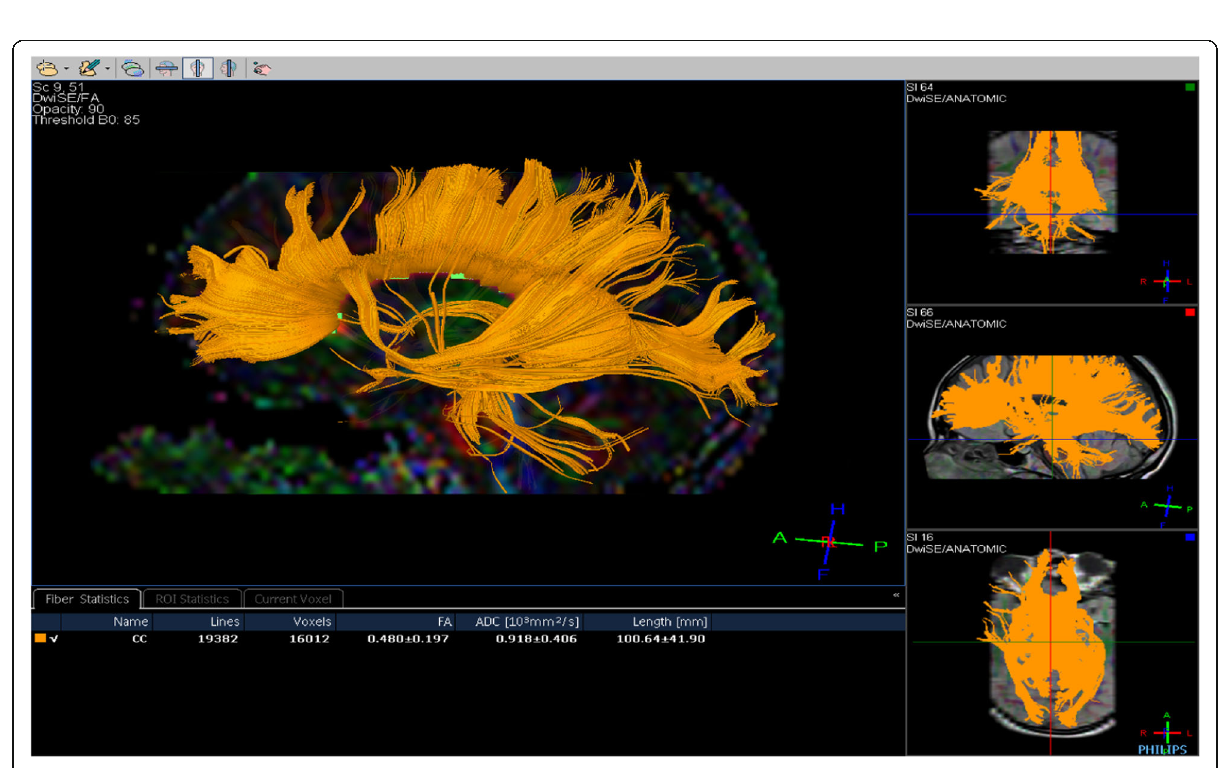
Fig. 3 Tractography of the corpus